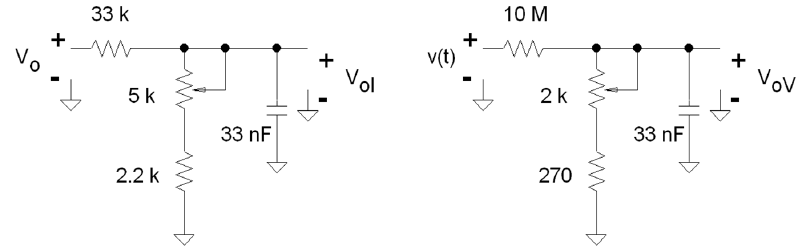
Figure 8. Voltage dividers and antialias filters for the current and voltage channels, respectively.